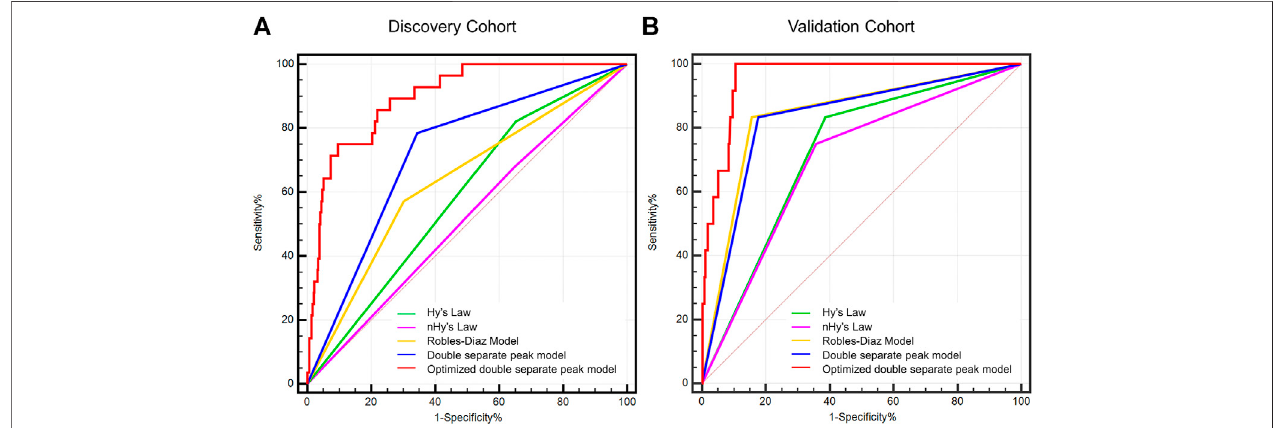
FIGURE 3 | Potency comparison among different models in predicting DILI-induced ALF. The AUROC of the DSP model was signi fi cantly superior to that of Hy ’ s lawandnHy ’ slawmodelsandcomparablewiththeRobles-DiazModel.ThepredictionpotencyofALFwasfurtherimprovedwhenincorporatedwithINRandALPatDILI onset, which was signi fi cantly better than the three previous models with an AUROC for predicting DILI-induced ALF of 0.899 (95% CI: 0.87 – 0.921) in the discovery cohort and 0.958 (95% CI: 0.933 – 0.975) in the validation cohort, respectively [Figure (A) and (B) ]. Abbreviations: AUROC, area under receiver operating characteristic; DSP, ALT, and TB double separate peak patterns; nHy ’ s Law, new Hy ’ s Law; DILI, drug-induced liver injury; ALT, alanine aminotransferase; TB, total bilirubin.